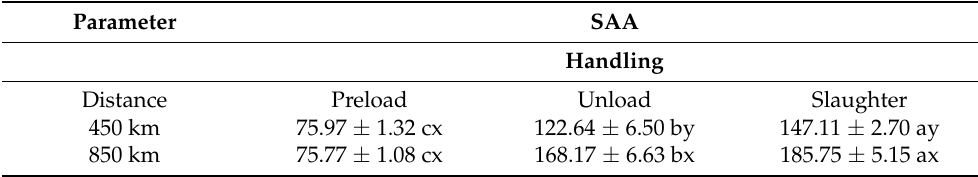
Table 10. Serum amyloid A (SAA) as affected by the interaction between handling and distance in road transported